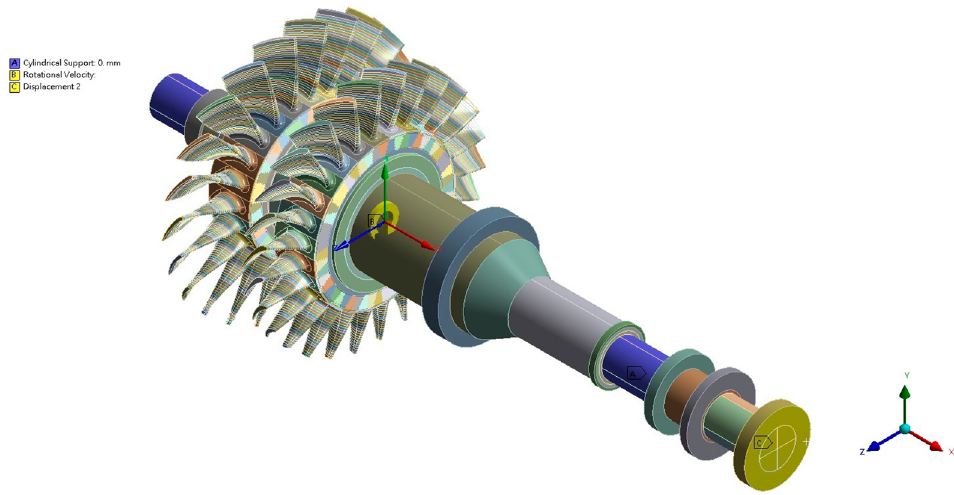
Figure 20. TRT rotor boundary conditions and speed load.